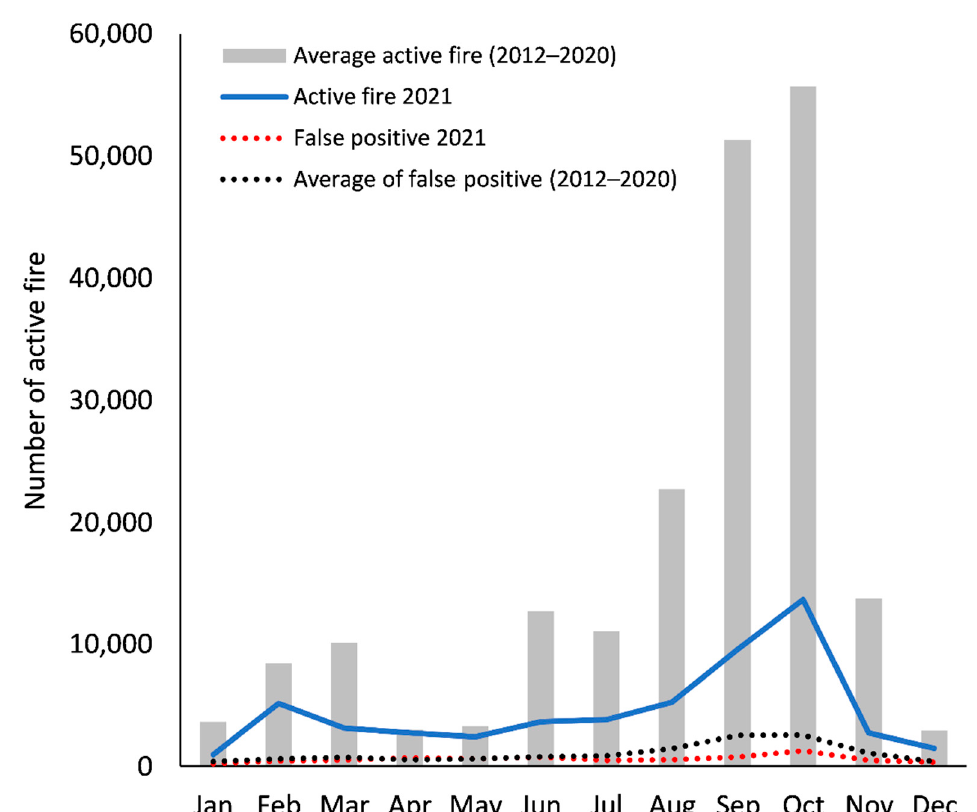
Figure 8. The monthly VIIRS active fires in Indonesia with the false-positive active fires extracted from the zone map of false active fires in year of 2021 and in the period of 2012 to 2020.